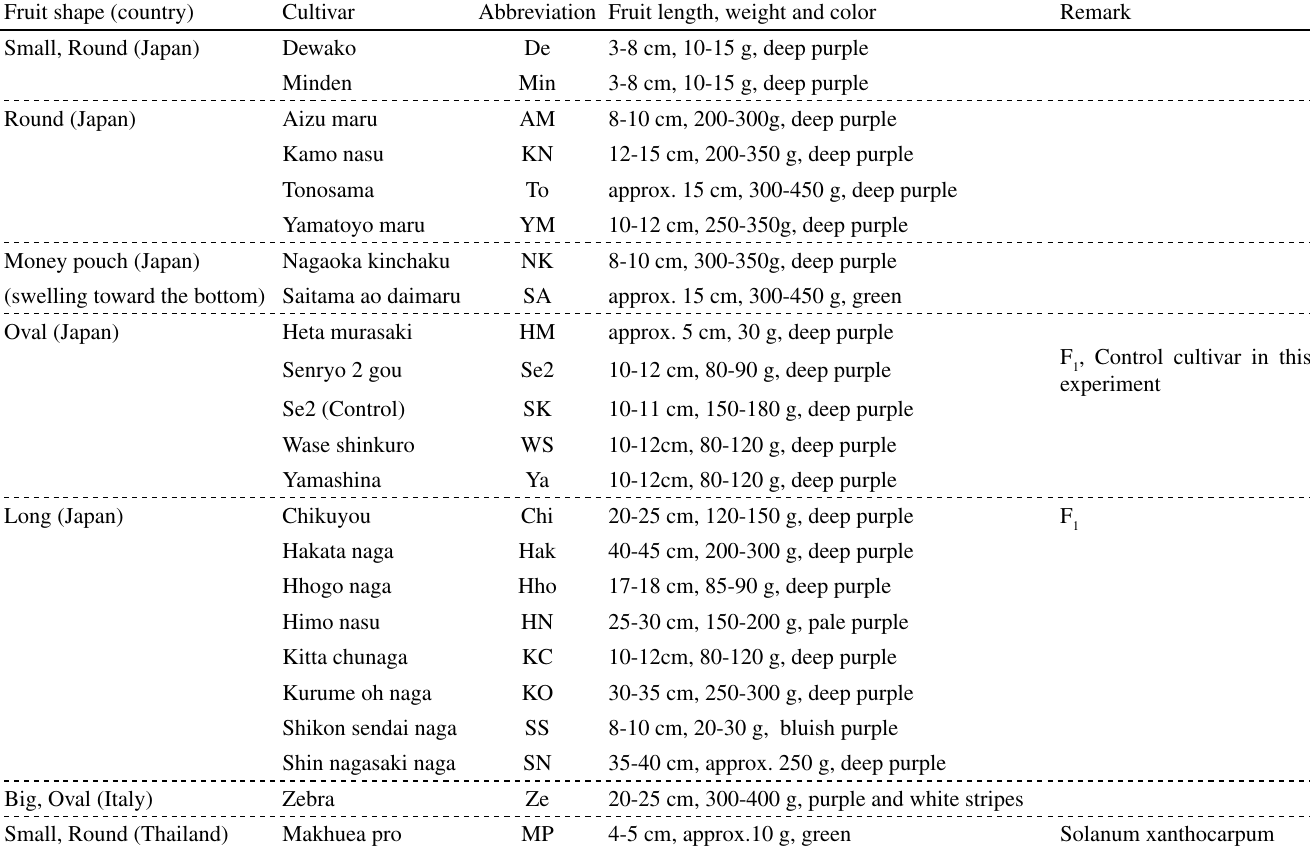
Table 1 - Eggplant cultivars used for the experiment Fruit shape (country) Cultivar Abbreviation Fruit length, weight and